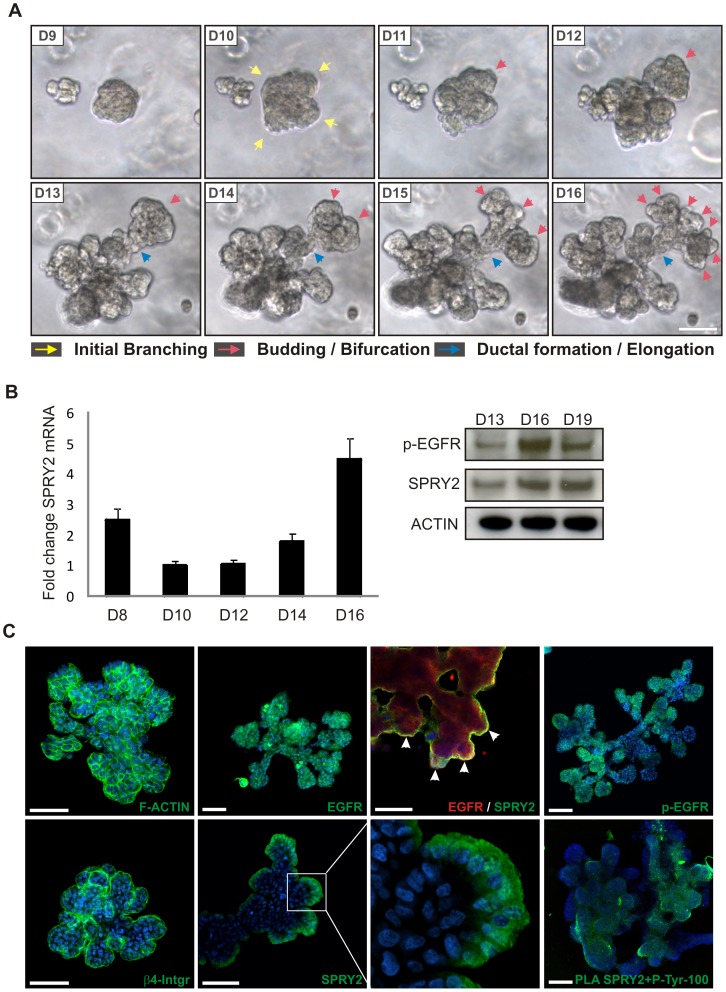
SPRY2 expression is correlated with critical points in branching morphogenesis of D492 breast stem cell line.
A) D492 cells generate branching structures when cultured in rBM. When seeded in rBM D492 cells generate TDLU-like structures. By generating in vitro TDLU-like structures it is possible to follow individual steps in the branching morphogenesis process. Until day 8 or 9 cells grow as single colonies. First sign of initial budding occurs at day 10 and 11 (yellow arrows) followed by duct elongation and bifurcation (blue and red arrows), respectively. B) SPRY2 expression shows a dramatic shift during TDLU formation in 3D culture. Colonies were isolated from 3D cultures at different time points as indicated. Initially at day 8 there is relative high expression of SPRY2 mRNA but its expression is reduced during initial budding but increases again during duct elongation and further bifurcation of complex branching. Western blot confirms that SPRY2 levels increase up to day 16 and remain high while pEGFR is slightly decreasing for day 16 to day 19. Actin was used as a loading control. C) pEGFR and SPRY2 are expressed at the growing tips of TDLU-like structures. D492-derived TDLU-like structures generated in 3D culture were stained with antibodies against SPRY2, EGFR, pEGFR, β4-integrin and F-actin. pEGFR was predominantly expressed at the branching tips while total EGFR had a more general distribution. SPRY2 was also expressed at branching tips but not in clefts. Co-staining of SPRY2 and EGFR show strong expression at the branching tips (arrows). F-actin staining gives a general outlook of a branching colony while β4-integrin outlines their connection to the surrounding rBM matrix. Phosphorylated SPRY2 (right) was analyzed using proximity ligation assay as described above. pSPRY2 was predominantly expressed at the branching tips showing similar pattern as total SPRY2. Cells were counterstained with TOPRO-3 nuclear stain. Bar = 100 µm.